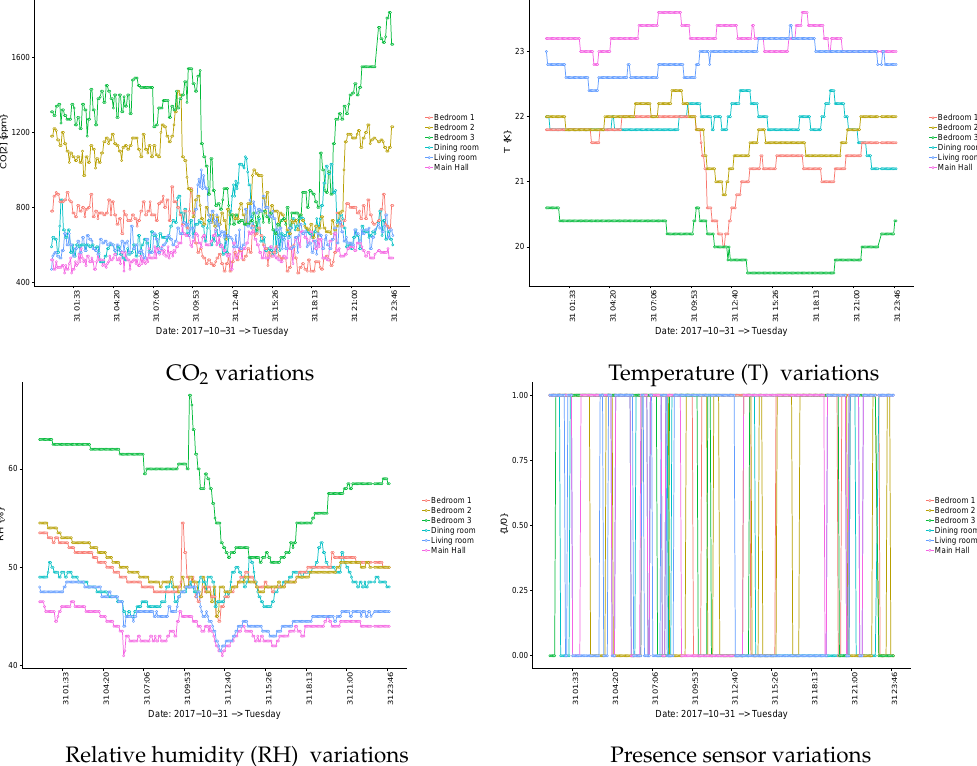
Figure 3. Sensor variations per room on 31 October